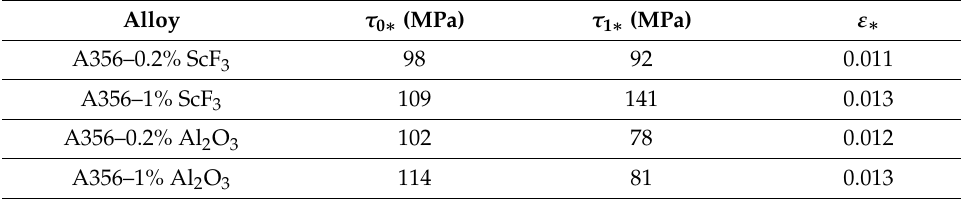
Table 2. The material constants τ 0 ∗ , τ 1 ∗ , and ε ∗